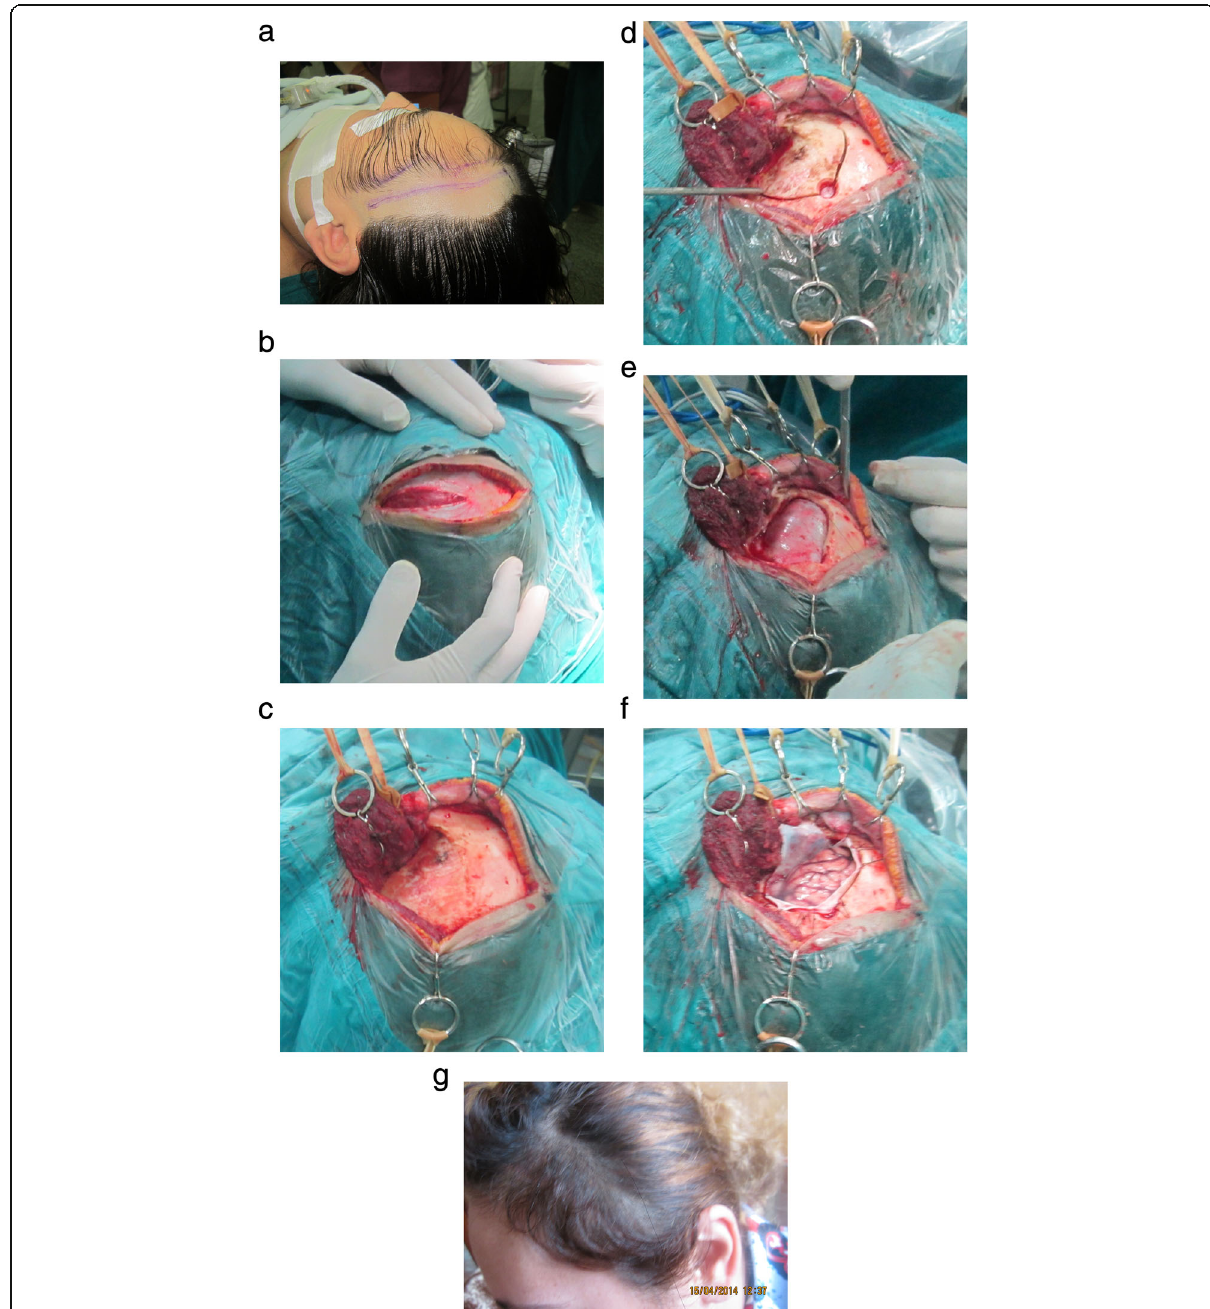
Fig. 1 Steps of lateral supraorbital approach on the left side. An oblique frontotemporal skin mark is placed behind the hairline after minimal hair shave ( a ). Skin and temporalis muscle are incised together (In the photograph the muscle is partially separated from the flap just for demonstration.) ( b ). The one-layer skin-muscle flap is retracted frontally ( c ). A single burr hole is placed just under the superior temporal line, and the bone flap is cut ( d ). Bone flap is detached, and sphenoid ridge is drilled ( e ). Dura is opened and tented with sutures ( f ). One-year postoperative image showing minimal atrophy of temporalis muscle and excellent cosmetic outcome ( g